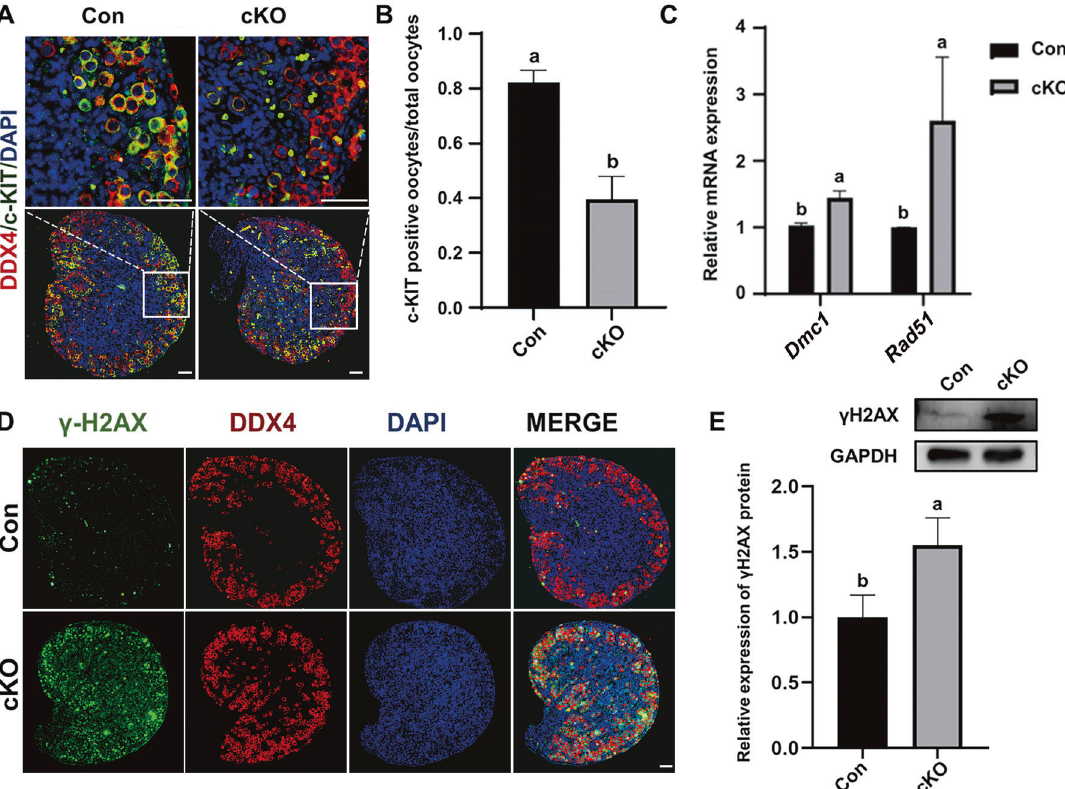
Fig. 5 Oocyte-speci fi c CK1 α deletion impairs the meiotic progression and causes the abnormalities in DNA double-strand breaks repair. A IF staining of DDX4 (red) and c-KIT (green) in 1 dpp mouse ovaries. DAPI (blue): nuclei. Scale bars: 50 μ m. B Number of c-KIT + oocytes accounting for the total oocytes. Different letters above columns indicate signi fi cant difference ( P < 0.05). C RT-qPCR analysis of cell meiosis- related genes. Results were presented as means ± SEM ( n = 3). Different letters indicate signi fi cant difference ( P < 0.05). D γ -H2AX (green) and DDX4 (red) dual staining of 1 dpp mouse ovary. DAPI (blue): nuclei. Scale bars: 50 μ m. E Western blot analysis of relative γ -H2AX protein levels of mouse ovaries at 1 dpp. Different letters indicate signi fi cant difference ( P < 0.05). The values are the means ± SEM of three independent